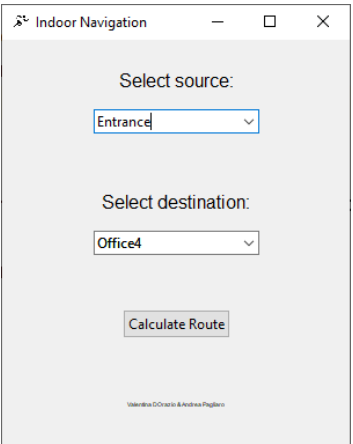
Figure 9. User dialog that prompts the user to choose source and